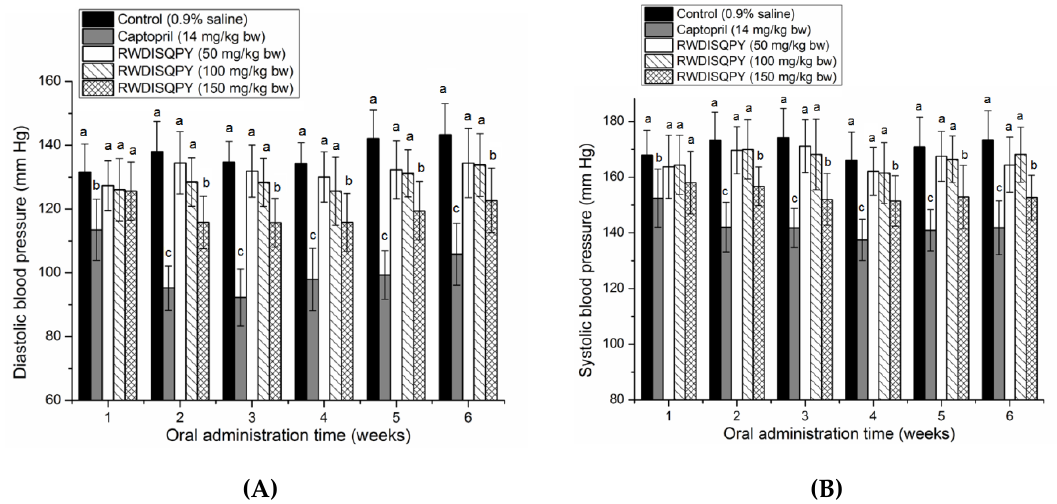
Figure 7. Effects of oral administration of RWDISQPY on diastolic blood pressure (A) and systolic Figure 7. E ff ects of oral administration of RWDISQPY on diastolic blood pressure ( A ) and systolic blood blood pressure (B) of spontaneous hypertensive rats (SHR). SHRs in the low-, middle- and pressure ( B ) of spontaneous hypertensive rats (SHR). SHRs in the low-, middle- and high-dose groups high-dose groups were orally administered peptides at 50, 100 and 150 mg/kg body weight (bw) were orally administered peptides at 50, 100 and 150 mg / kg body weight (bw) every day, respectively. every day, respectively. SHRs of the positive control group were given captopril at 14 mg/kg body SHRs of the positive control group were given captopril at 14 mg / kg body weight once daily, whereas weight once daily, whereas the SHRs in the blank group were just given saline (0.5 mL). Different the SHRs in the blank group were just given saline (0.5 mL). Di ff erent small letters above the bars (a–c) small letters above the bars (a–c) indicate significant differences ( p < 0.05) . indicate significant di ff erences ( p < 0.05).